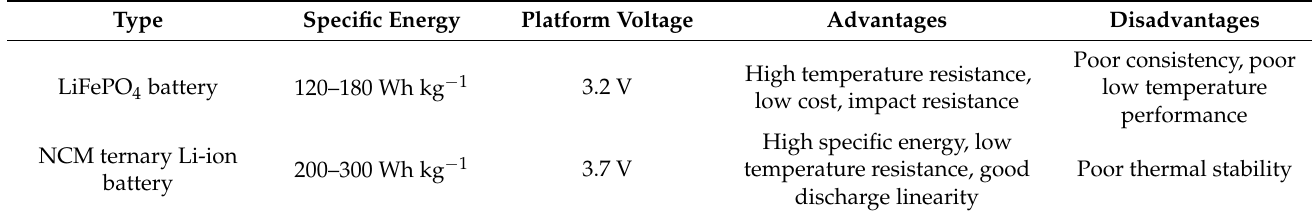
Table 1. Performance comparison of a LiFePO 4 battery and an NCM ternary Li-ion